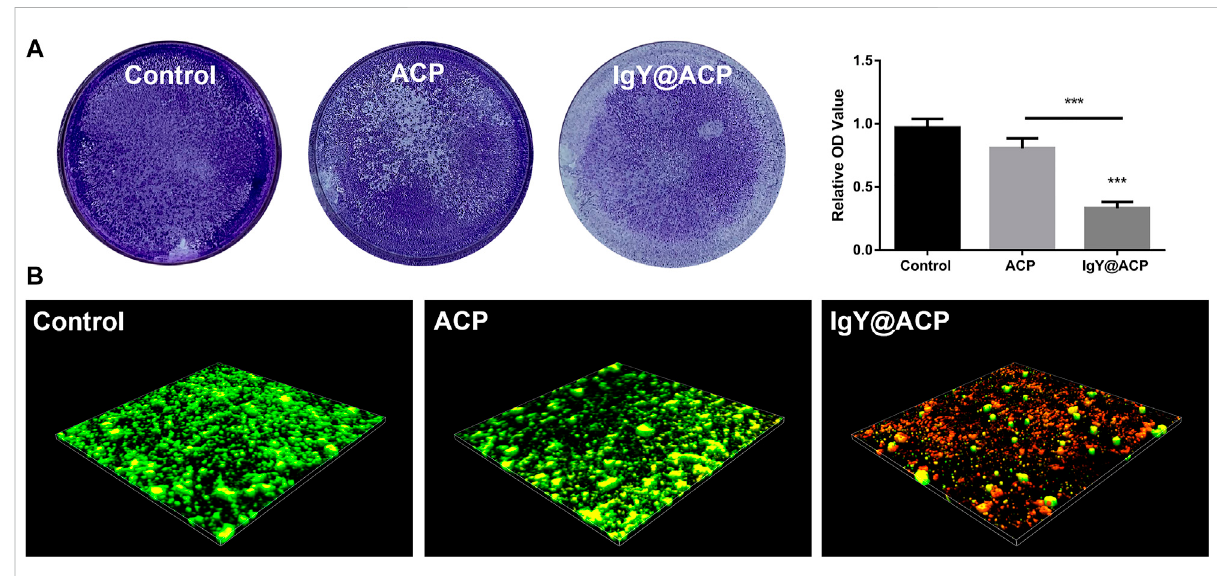
FIGURE 9 The bio fi lm formation of S. mutans after treatment with control, ACP, and IgY@ACP. Crystal violet staining with quantitative analysis (A) and live-/dead-stained 3D images (B) . Statistical signi fi cance was set at * p < 0.05, ** p < 0.01, and *** p <